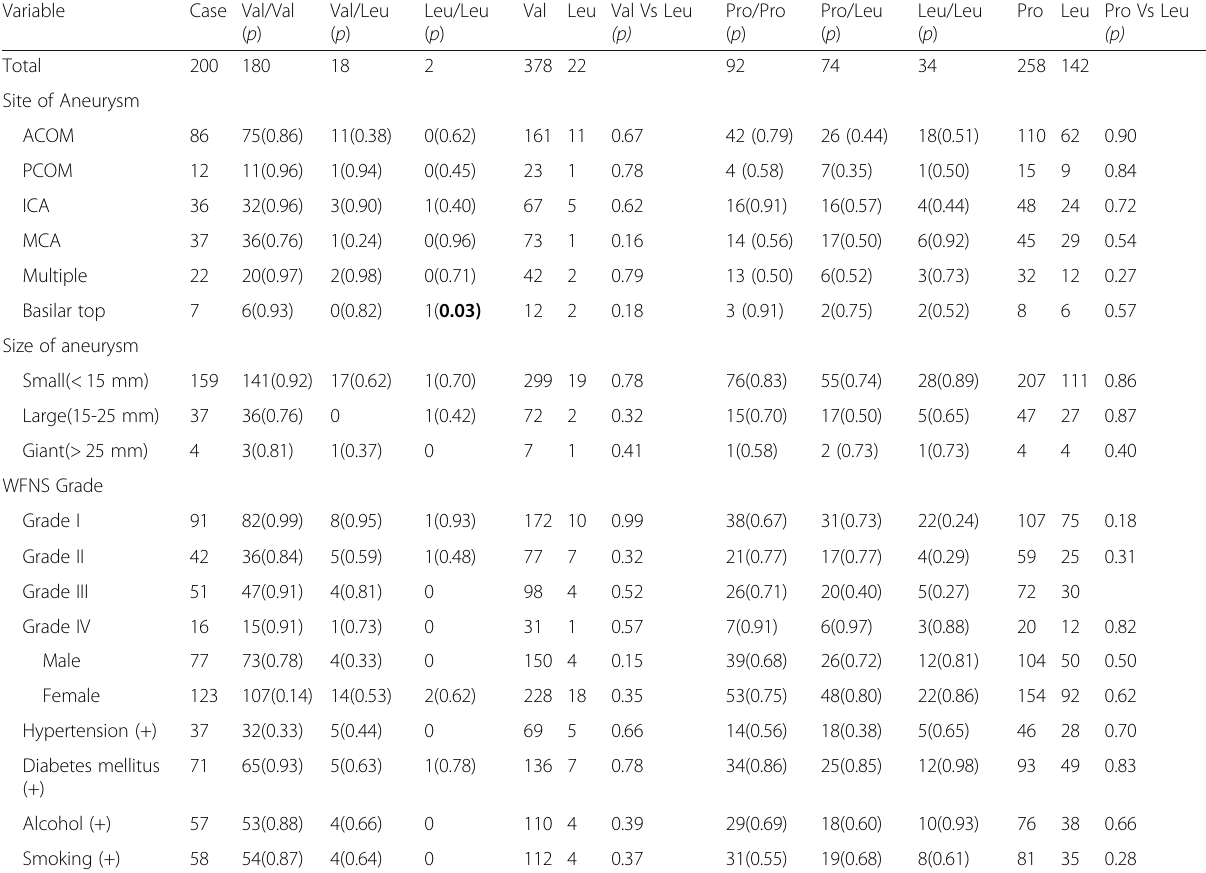
Table 3 c.103G > T (p.Val35Leu) and c.1694C > T (p.Pro564Leu) Variants in aSAH